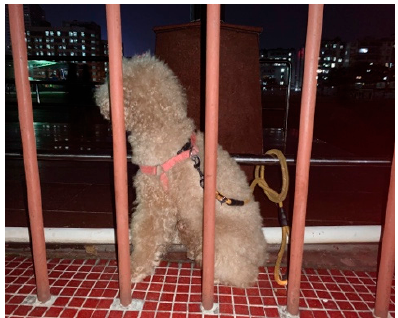
Figure 1. Listen is waiting while the couple interviewees No. 1 exercise.